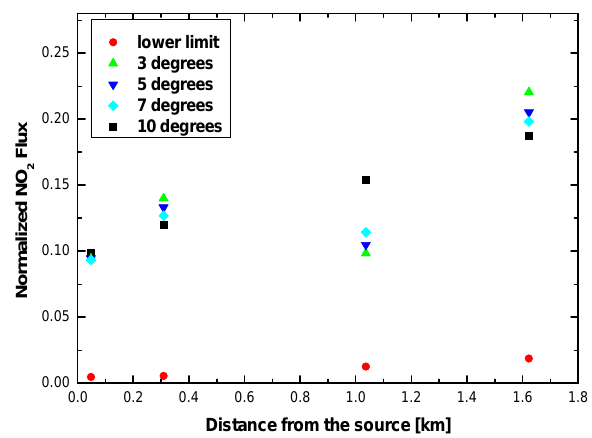
Fig. 5. Normalized NO 2 -fluxes ¯ S NO / ¯ S SO (after Eq. 7); the mean 2 2 values ¯ S NO were calculated by considering the slant column 2 , SO 2 densities restricted to different intervals of elevation angles (3 ◦ , 5 ◦ , and 7 ◦ ) and the whole range 1 ◦ –10 ◦ . The result for the lower limit (see Fig. 4) is also